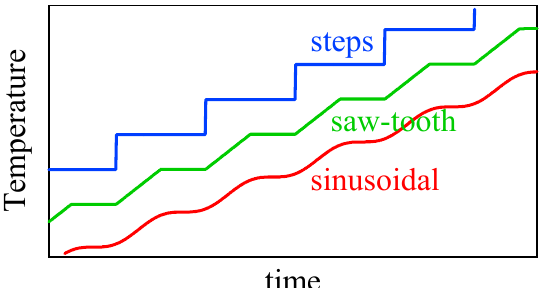
Figure 1. Various types of periodic modulation in temperature of a temperature-modulated scanning calorimetry for the case of heating at constant rate under the condition of heating only.